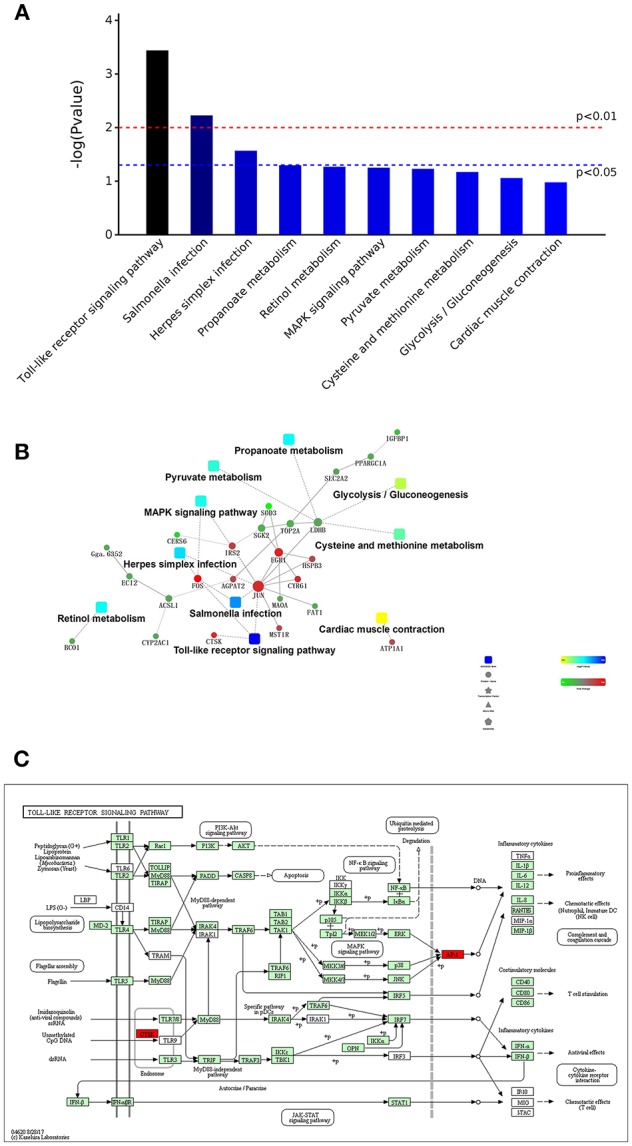
KEGG pathway cluster analysis and correlation analysis of DEGs. (A) Distribution of enriched KEGG pathways. (B) Correlation analysis of DEGs. (C) Daidzein treatment regulated the Toll-like signaling pathway. The key factors are marked in red.